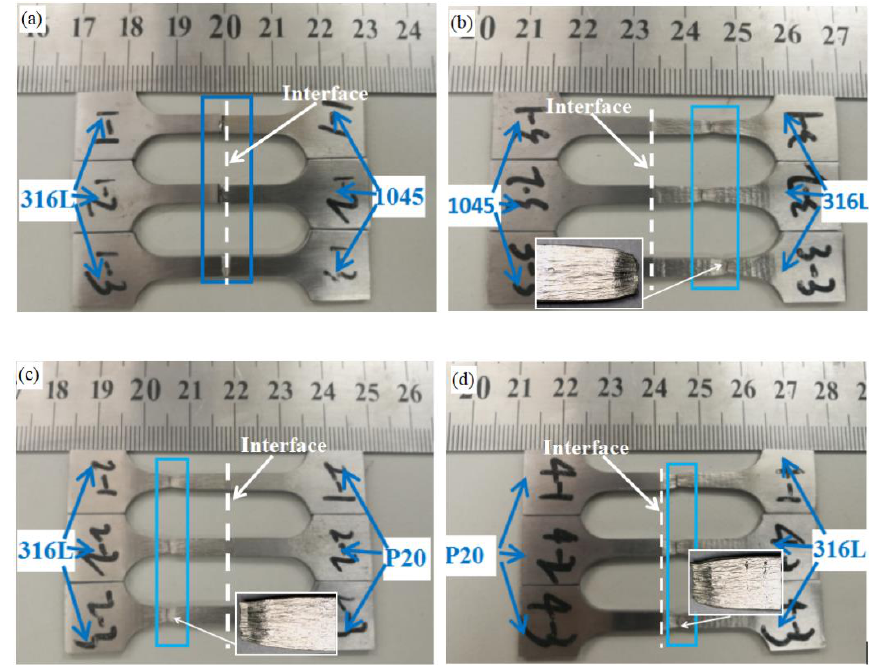
Figure 12. Hybrid formed plate tensile samples: ( a ) 316 L with 1045 steel; ( b ) 316 L with 1045 steel under preheating; ( c ) 316 L with P20 steel; ( d ) 316 L with P20 steel under preheating.